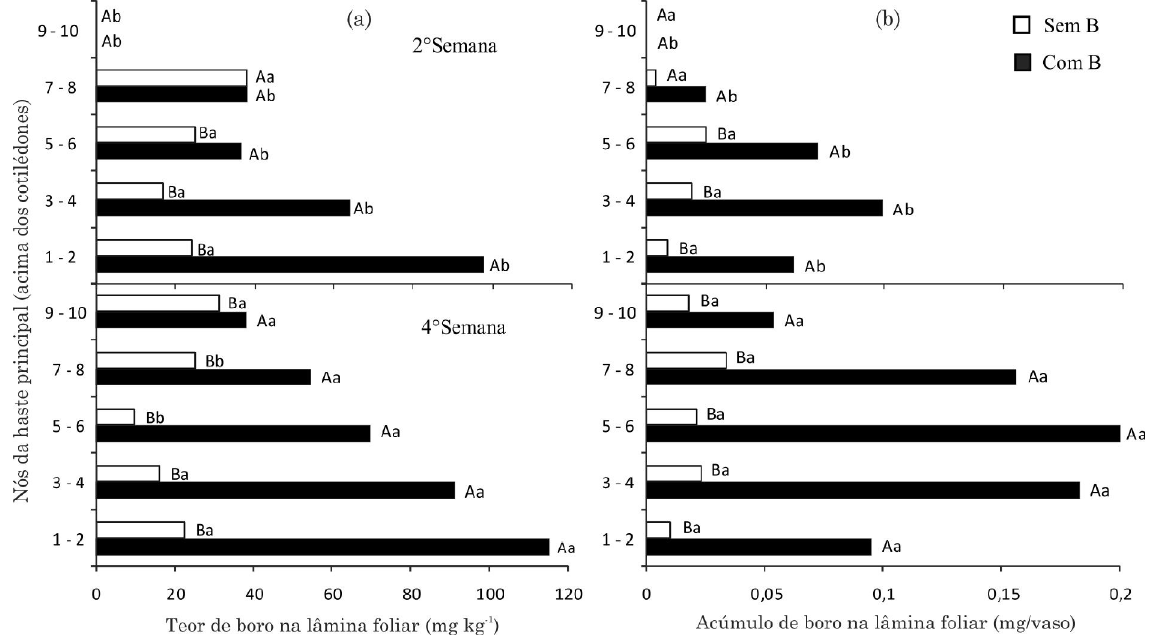
4. Teor (a) e acúmulo (b) de boro nas folhas de diferentes nós da haste principal, na segunda e quarta semanas de avaliação, em cultivares de algodoeiro com e sem boro (média de quatro cultivares). Letras maiúsculas distintas indicam diferença significativa entre doses na mesma semana, e minúsculas indicam diferença significativa entre semanas, na mesma dose